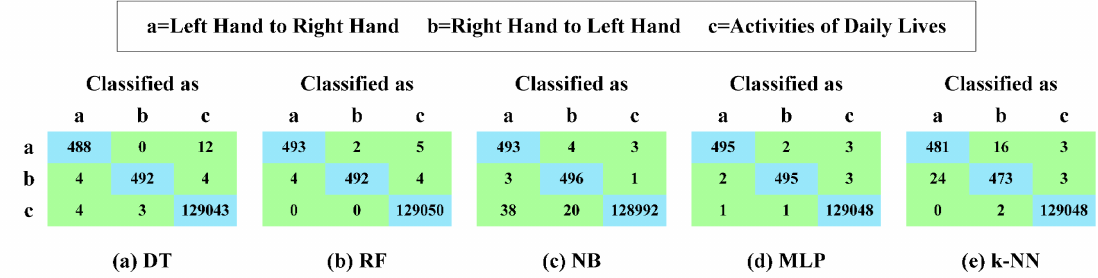
Figure 20. Confusion matrices of different recognition algorithms. ( a ) DT; ( b ) RF; ( c ) NB; ( d ) MLP;